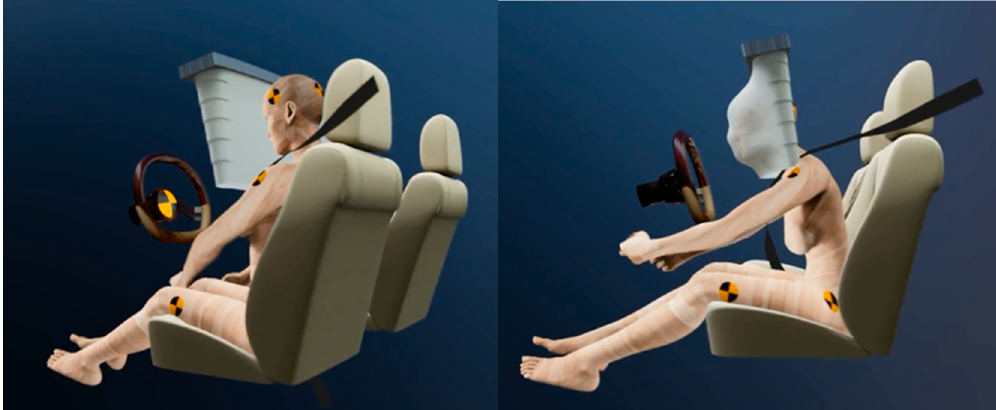
Figure 2. Nanobag